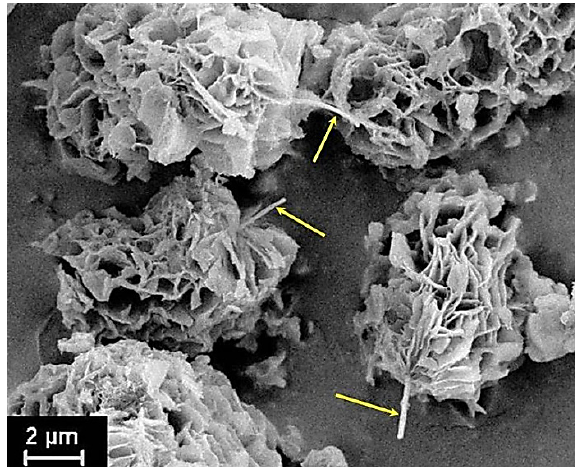
Figure 1. Polyimide R-BAPB nascent powder particles synthesized with added VGCF nanofibers (VGCFs are shown by yellow arrows).